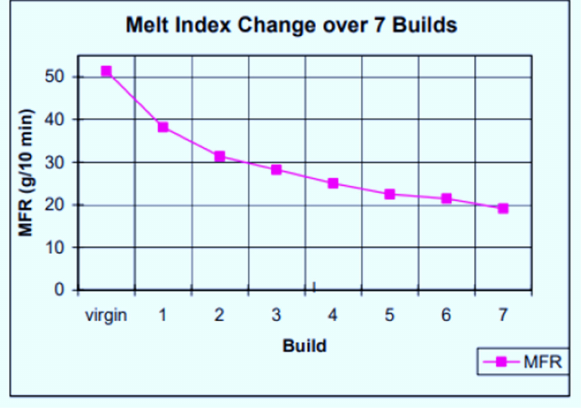
Figure 9. MFR of PA 12 over seven builds [19].